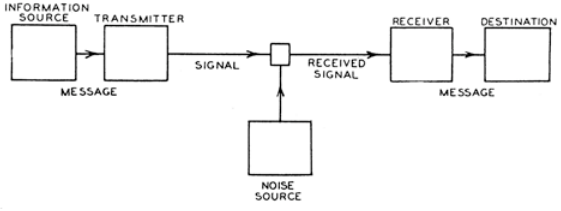
Fig. 3. Shannon’s communication scheme.